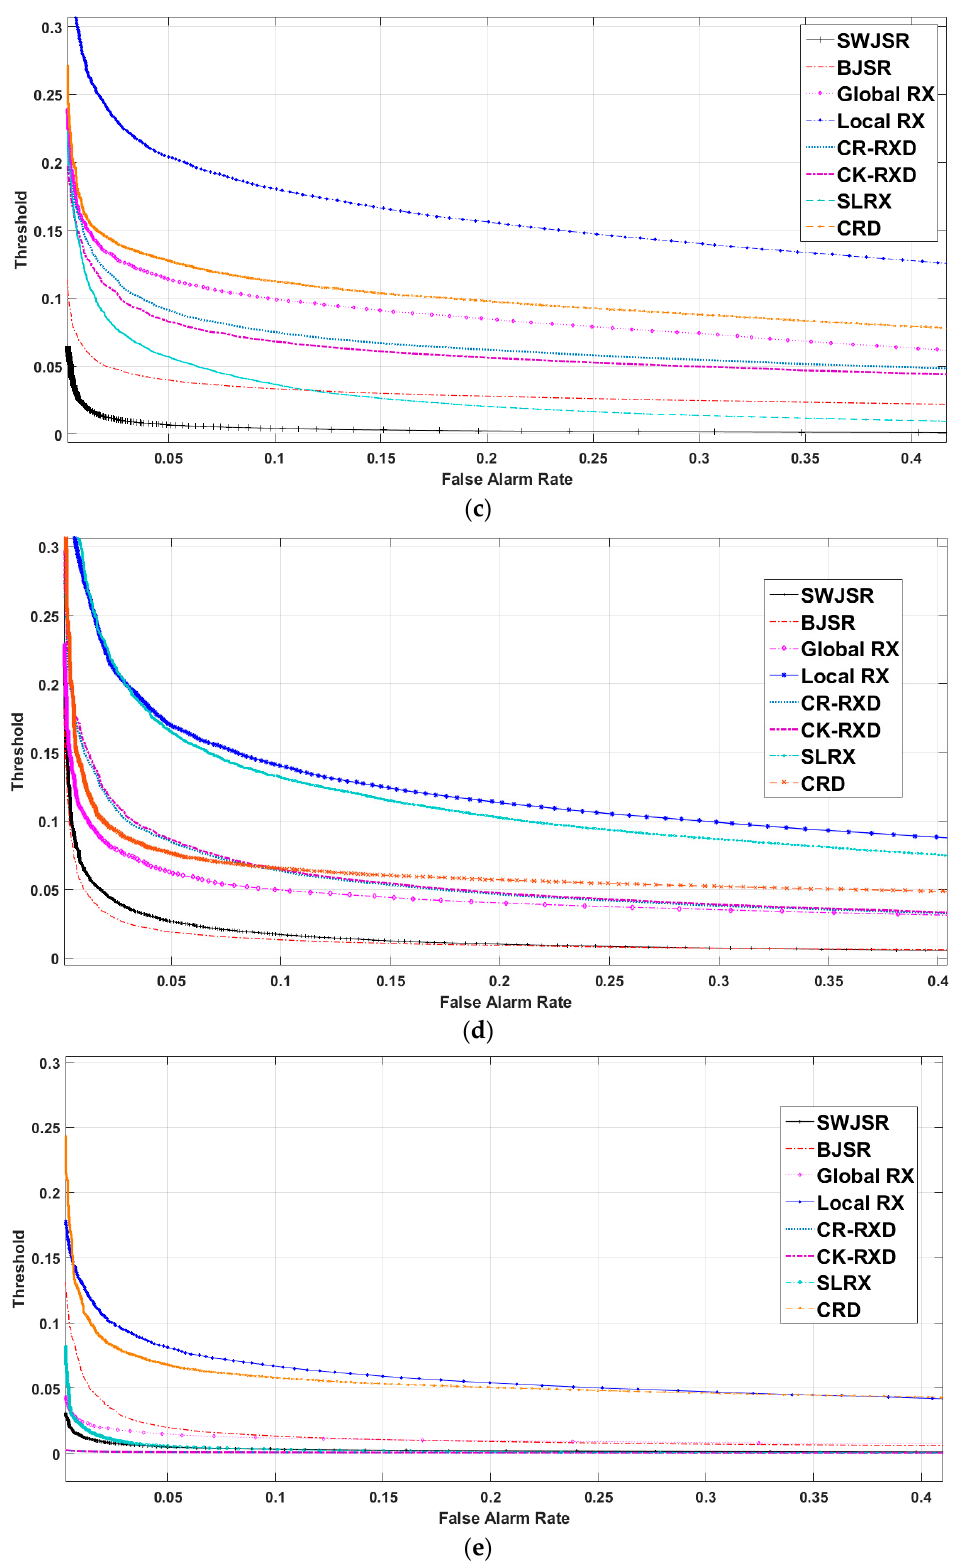
Figure 10. 2-D ROC ( P F , Th ) of the anomaly detection algorithms: ( a ) real RIT dataset; ( b ) real San Diego dataset; ( c ) real Viareggio dataset; ( d ) implanted RIT dataset; and, ( e ) destructed RIT dataset.